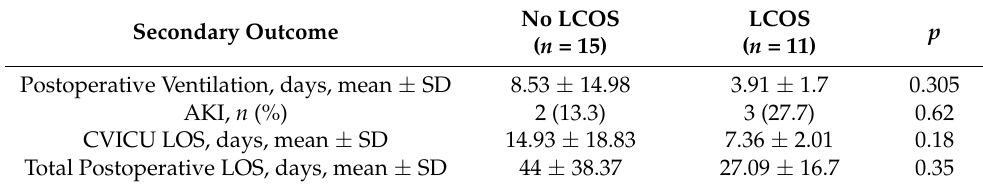
Table 4. Group 2 secondary outcomes stratified by primary